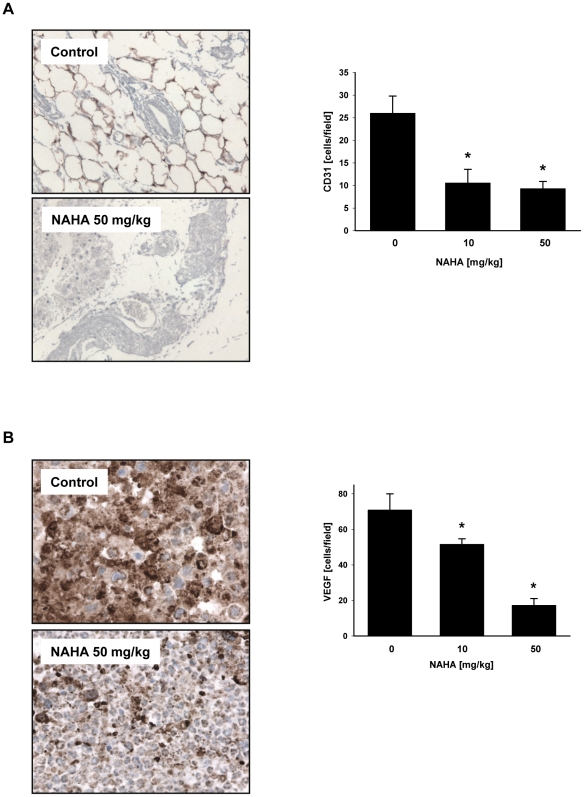
Expression of CD31 and VEGF in tumors.The expression of (A) CD31, and (B) VEGF were quantified as described in
Materials and Methods
. Data are mean ± SD (n = 6–10), * significantly different from control (p<0.05) by ANOVA.